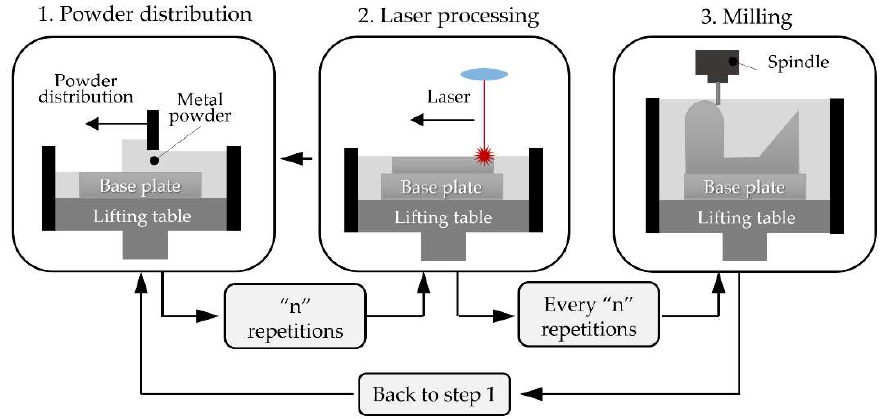
Figure 9. Additive and subtractive operation combination on which the Matsuura hybrid machines are based [131].